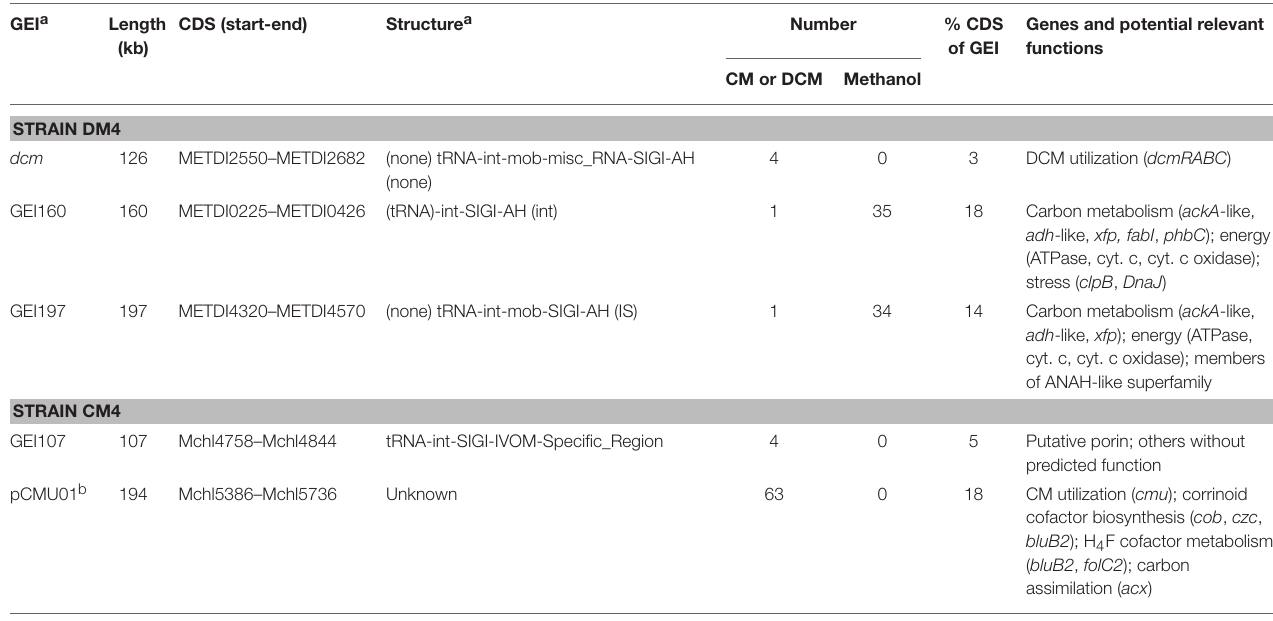
TABLE 3 | GEIs containing genes with differential transcript